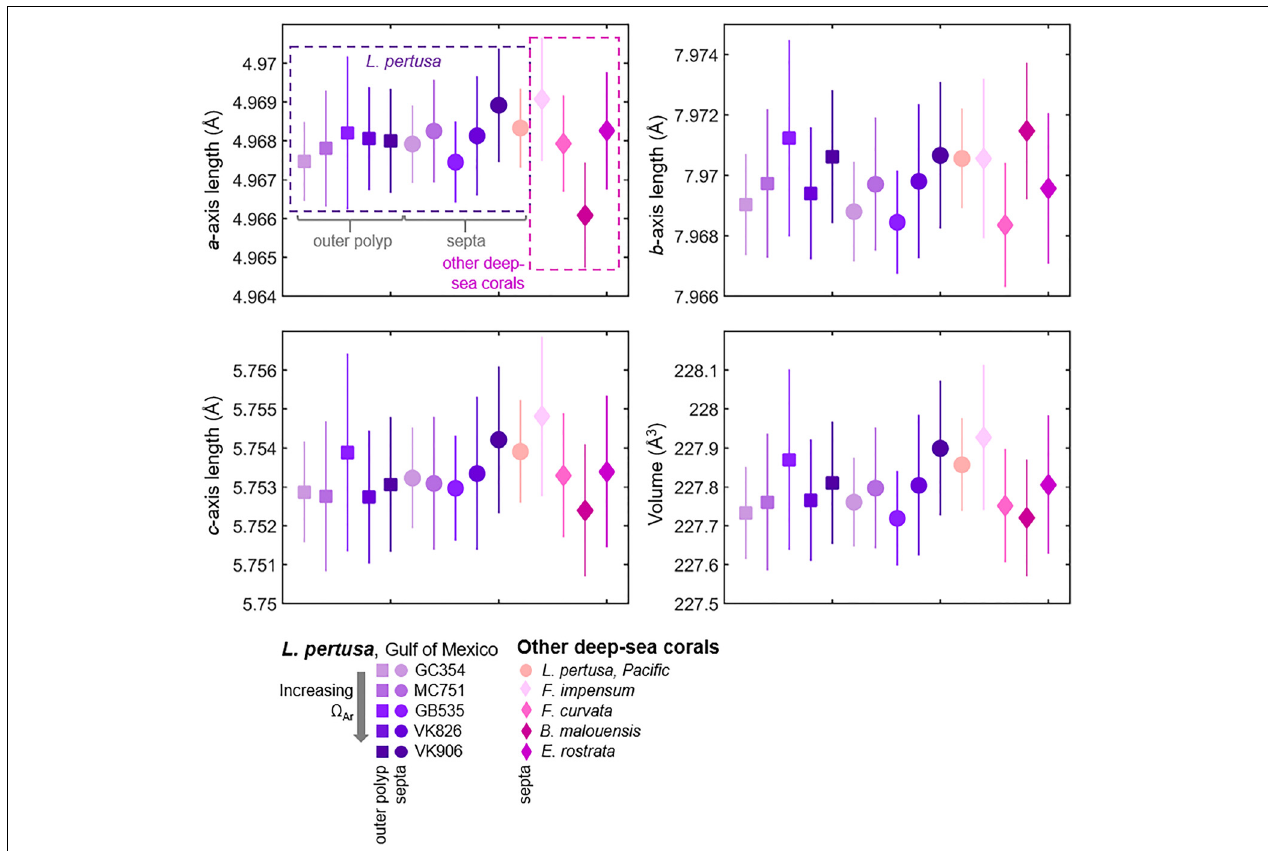
FIGURE 2 | Crystallographic lattice parameters of Lophelia pertusa aragonites from the Gulf of Mexico, compared to other species and localities of deep-sea corals. Samples are taken from the area outside of the polyps (squares) and from septa (circles and diamonds). Each point is an average of four replicates. Error bars represent estimated standard deviations.